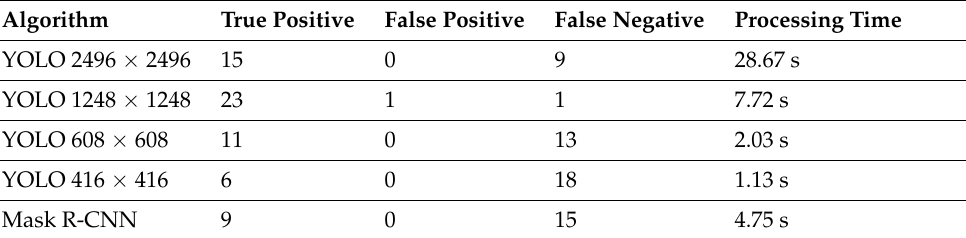
Table 1. Pedestrian detection from distance. Resolution 1920 × 1080. Number of pedestrians 24.